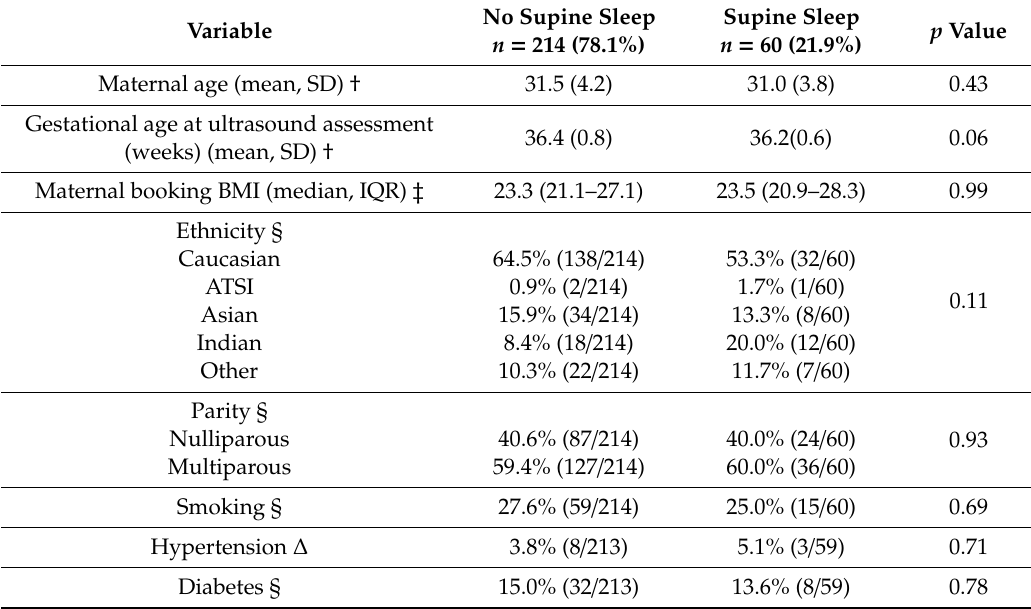
Table 1. Maternal demographics by maternal sleep